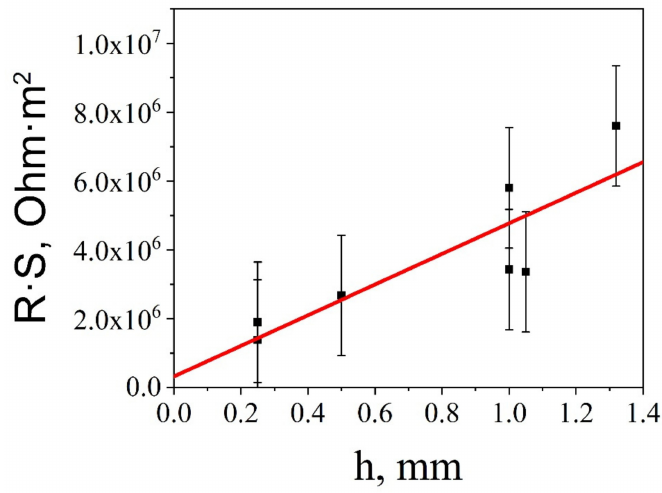
Figure 5. Total resistance times surface area of BTO + 10Mn ceramics as a function of the thickness of ceramic discs. The intersection with the ordinate axis yields the contact resistance of the